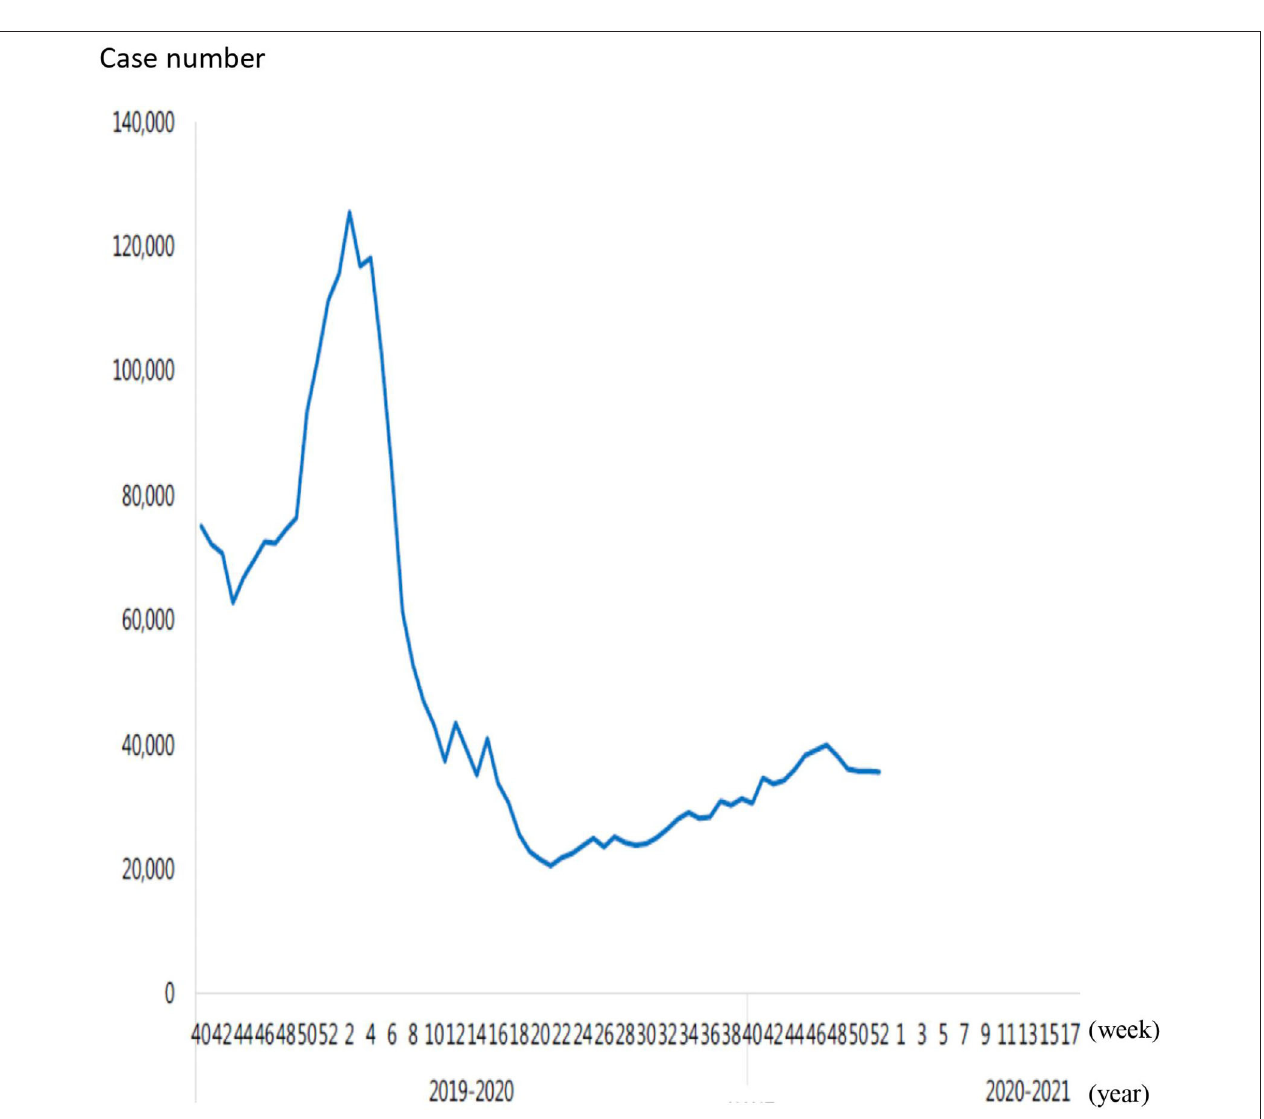
FIGURE 1 | The total number of outpatient and emergency visits for influenza-like illness in 2019, 2020 and 2021.